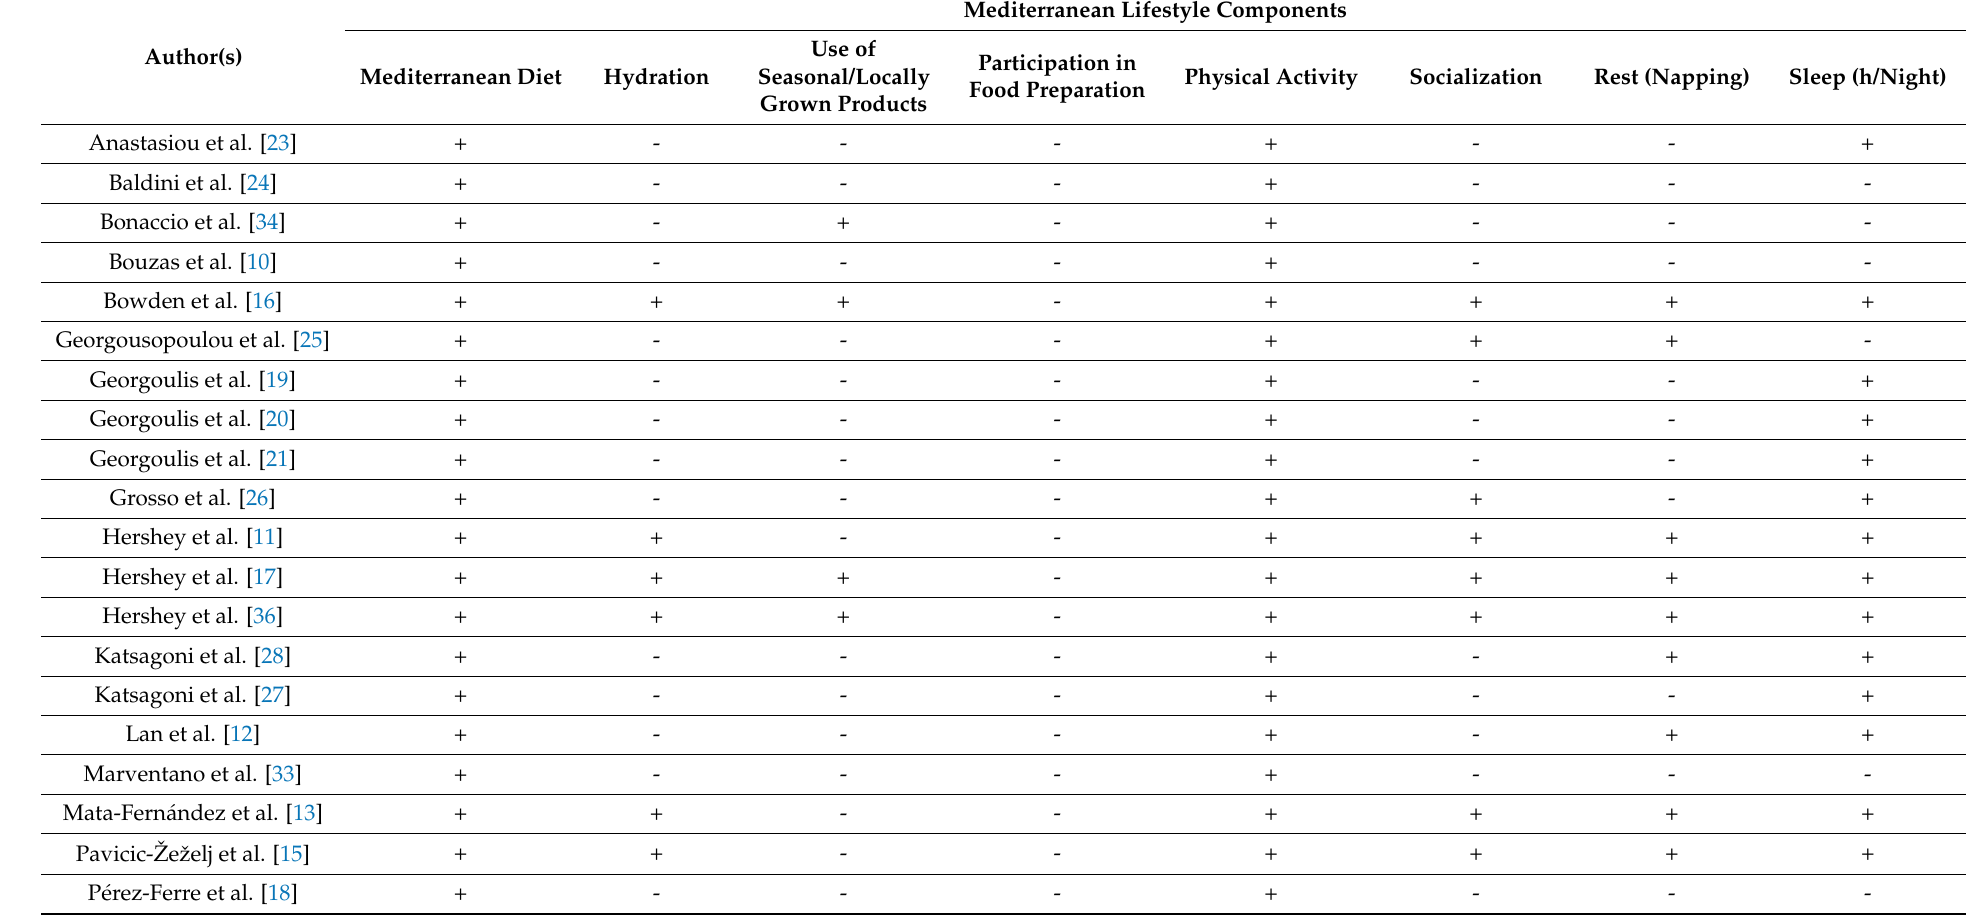
Table 4. Mediterranean Lifestyle components evaluated in each